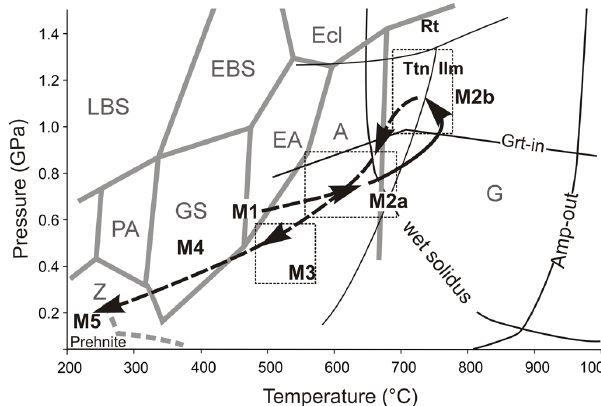
Fig. 12. Proposed synthetic P - T path for the Sabzevar granulites. Metamorphic facies boundaries are after Bucher and Frey (2002). The grid showing wet melting regimes for basaltic system with stability of the main index minerals indicated is after Vielzieuf and Schmidt (2001). Experimentally determined P - T field phase boundaries for Ti-phases (Ttn, Ilm, Rt) are after Liou et al. (1998). The prograde M 1 -to-M 2 and the retrograde M 3 -to-M 5 paths are only tentative. Key to symbols: A, amphibolite facies; EA, epi- dote amphibolite facies; EBS epidote blueschist facies; Ecl, eclogite facies; G, granulite facies; GS, greenschist facies; LBS, lawsonite- blueschist facies; PA, pumpelliite-actinolite facies; Z, zeolite facies. Mineral Abreviations are after Whitney and Evans